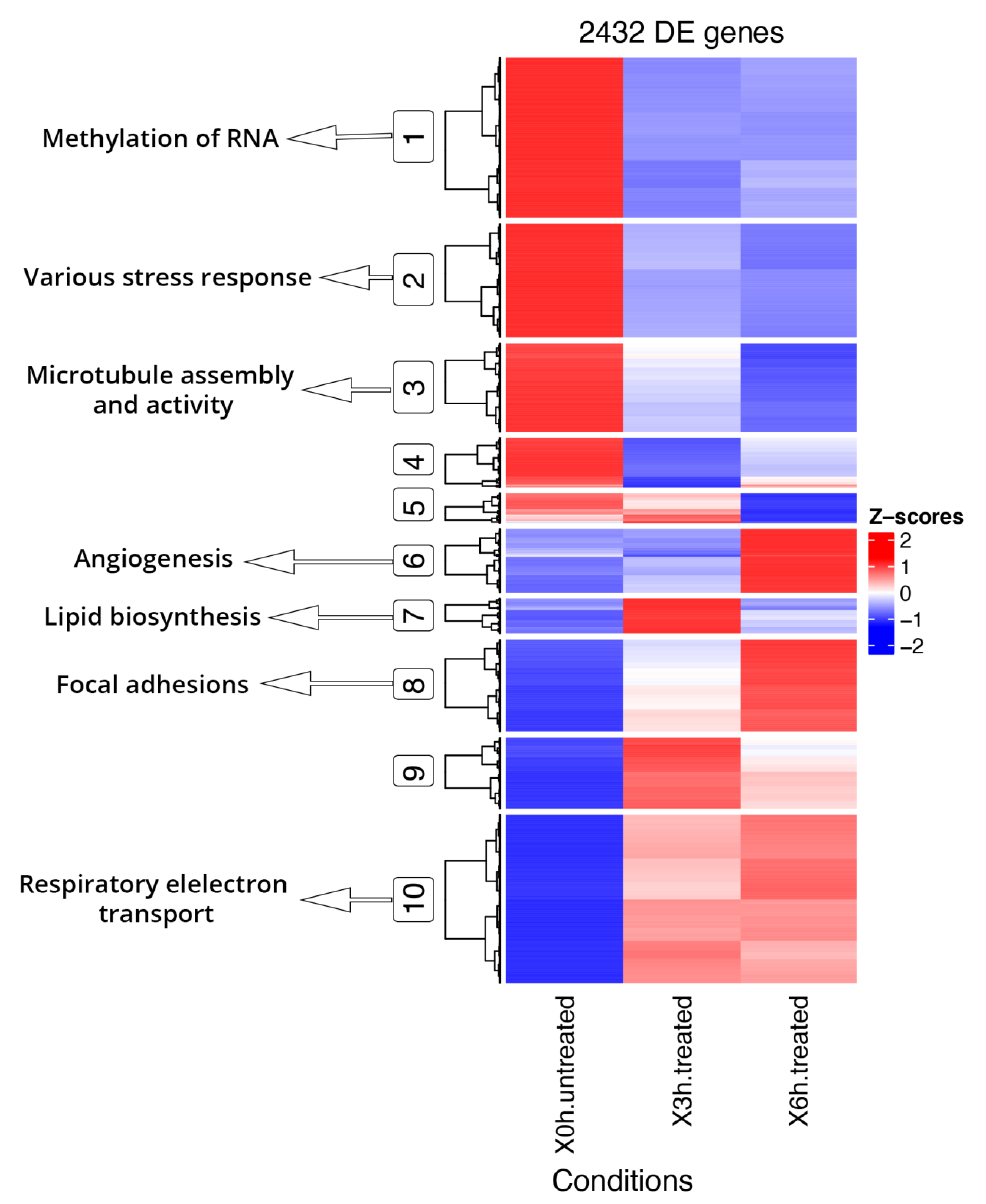
Figure 4. Hierarchical clustering and heatmap of DE genes and Key GO terms. DE genes show segregation into 10 coexpressed clusters, of which the main ones related to oxidative stress were highlighted (circled) and linked to GO specific terms. Full results of GO enrichment analyses are shown in Tables S6 and S7. The z-score scale represents mean-subtracted regularized log-transformed transcripts per million (TPMs) .